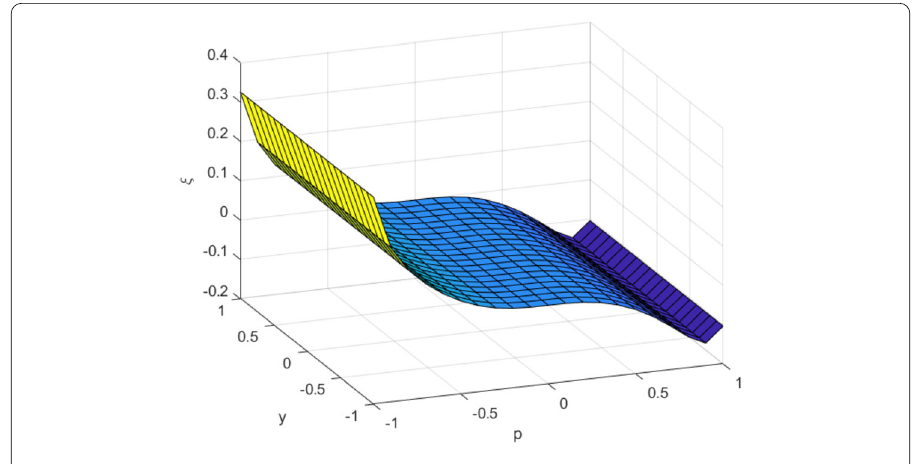
y 14 – y (cid:2) 0, at v = 0, ∀ p , ∀ y ∈ [–1,1]